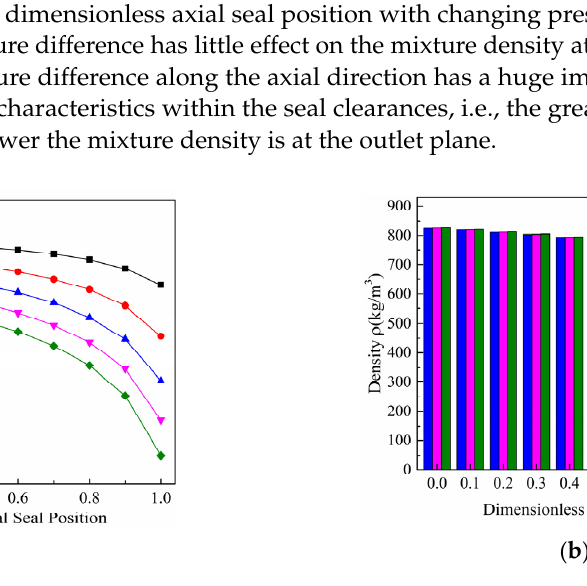
Figure 6. Mixture density along the axial direction under different conditions. ( a ) Under different inlet GVFs with a constant Δ P of 31 bars, ( b ) under different pressure differences with a constant inlet GVF of 10%.